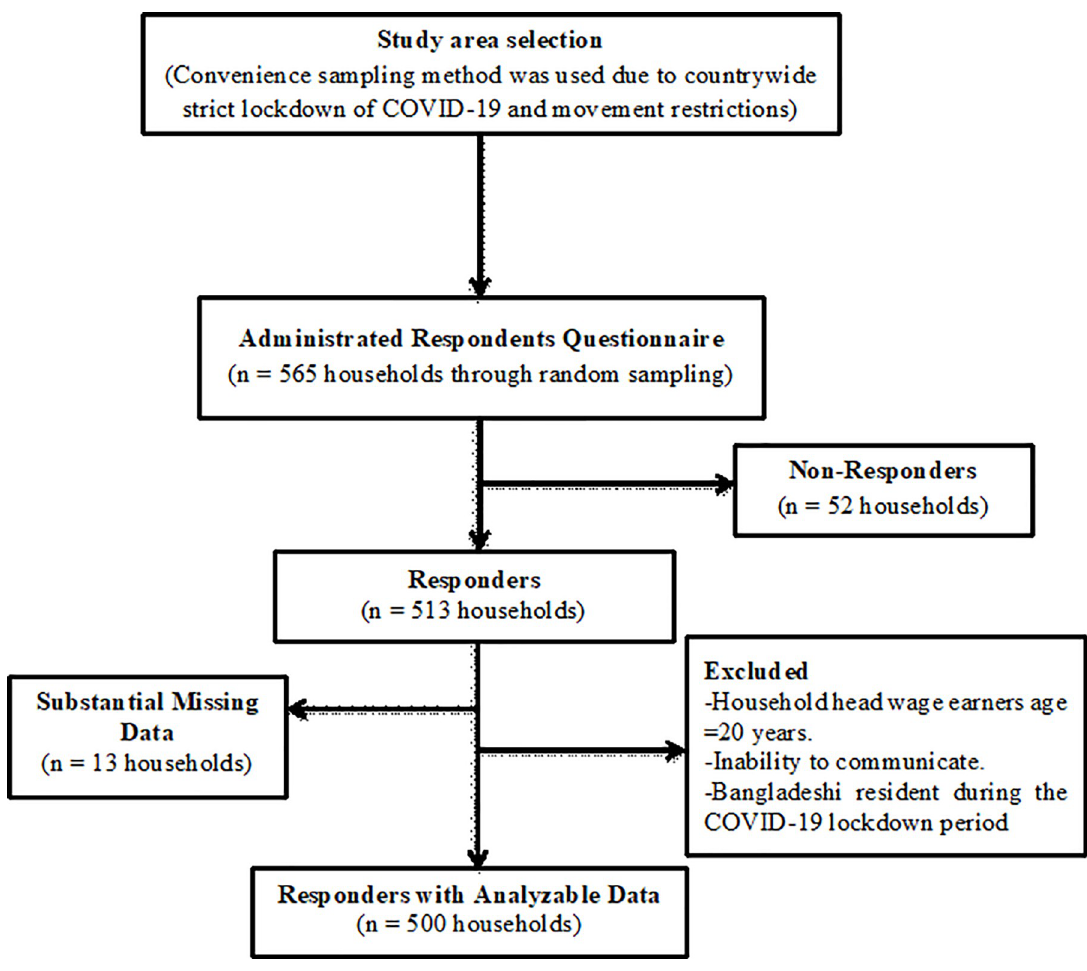
Fig 1. Flow chart of respondent’s